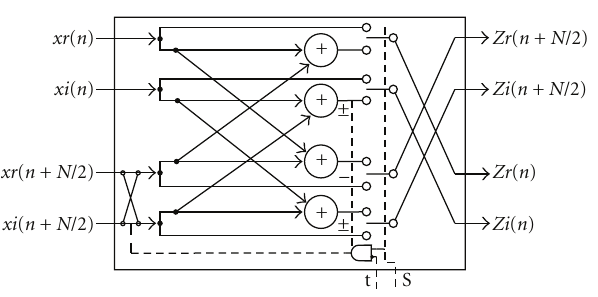
Figure 6: R2 2 SDF BF2 II